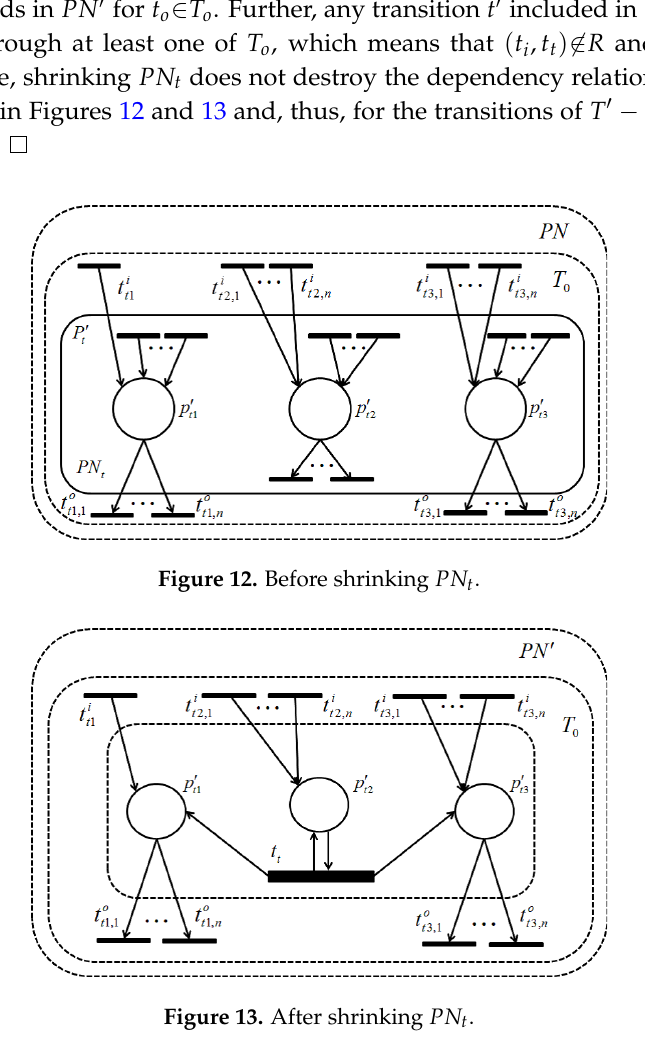
Figure 13. After shrinking PN t